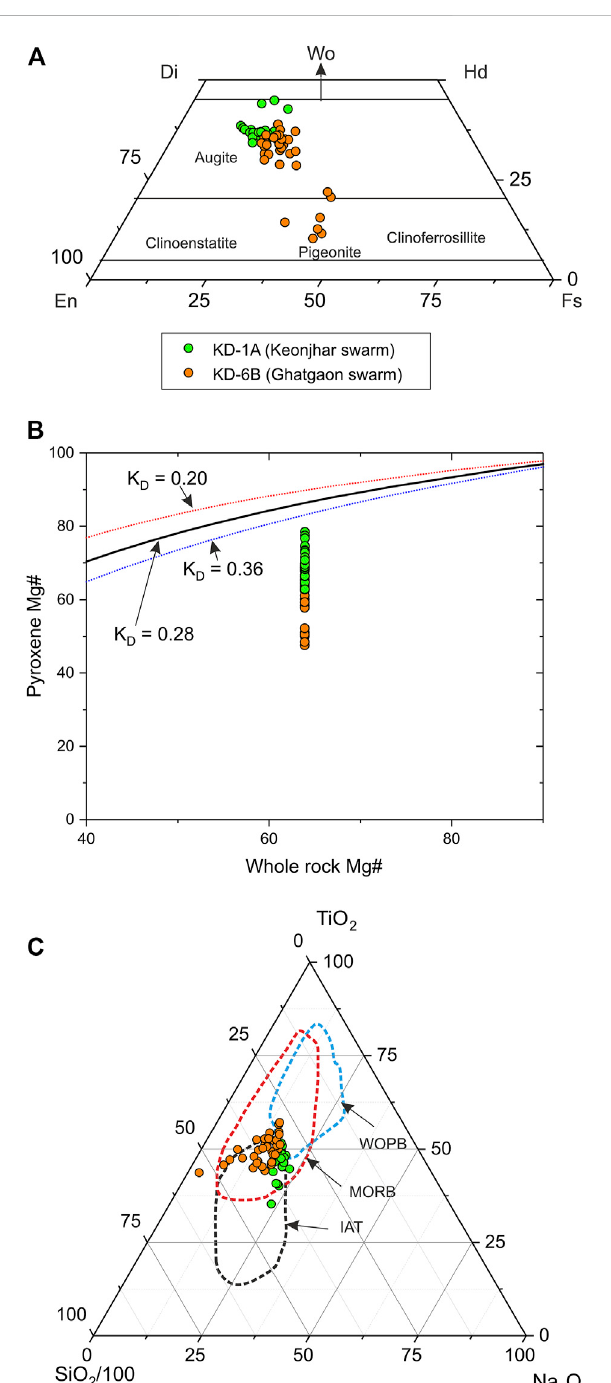
crustal contamination or crustal components in the source. The age, distribution and cross-cutting relationship of dyke swarms are inconsistent with their origin related to a subduction zone (Figure 8) (Dasgupta et al., 2019; Adhikari et al., 2021; Pandey et al., 2021). The dyke swarms are distributed in an intracratonic regime and the stabilization of the Singhbhum craton occurred during Mesoarchean (Dey et al., 2017; Olierook et al., 2019; Srivastava et al., 2019; Hofmann et al., 2022). The emplacement of these dyke swarms occurred at discrete magmatic episodes from Neoarchean to Mesoproterozoic, and their subparallel distribution and areal extent of more than 100 km are consistent with an intracontinental rift system (Pandey et al., 2021)